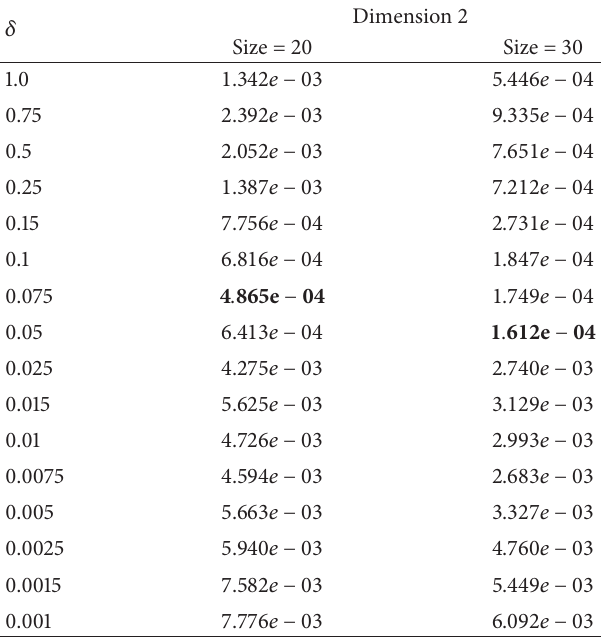
Table 13: Different values of parameter 𝛿 and respective mean best fitness for Schaffer’s f6 test